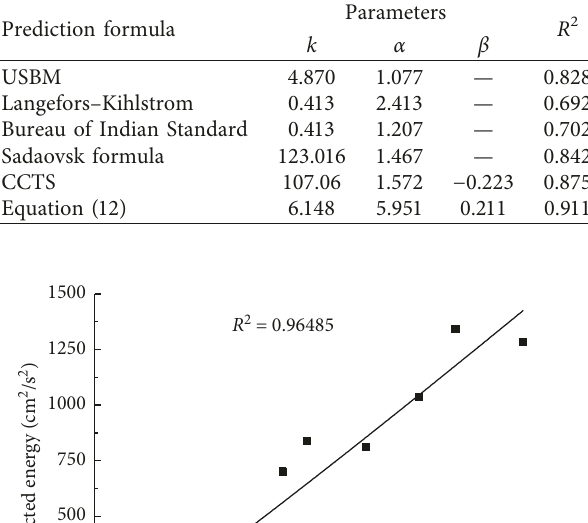
Figure 9: Attenuation laws of the energy proportions along with distance.